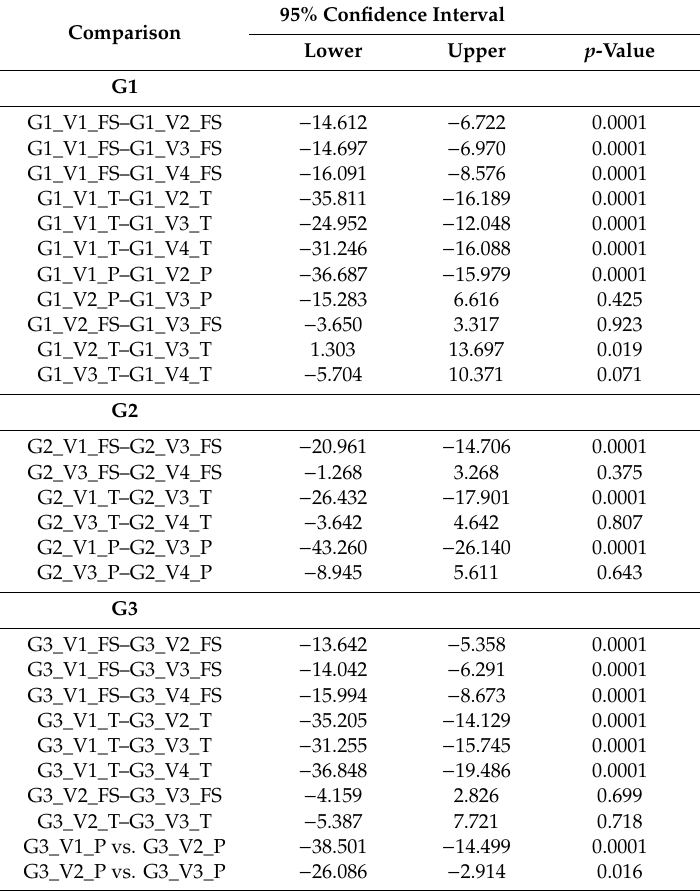
Table 6. Comparison of changes rectal volume sensation for G1, G2,